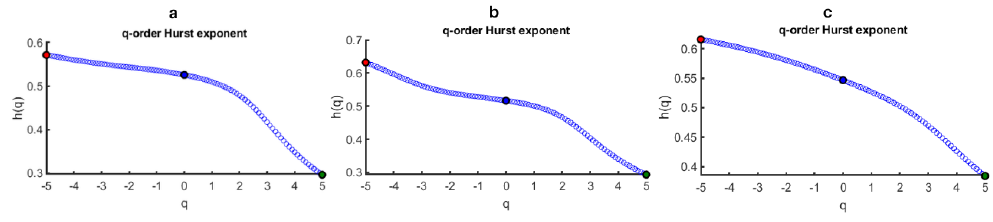
Figure 10. Plots of h ( q ) on q for: ( a ) full sample (1 January 2013 to 26 July 2020), ( b ) 1st sub-sample (1 January 2013 to 16 July 2017), and ( c ) 2nd sub-sample (17 July 2017 to 26 July